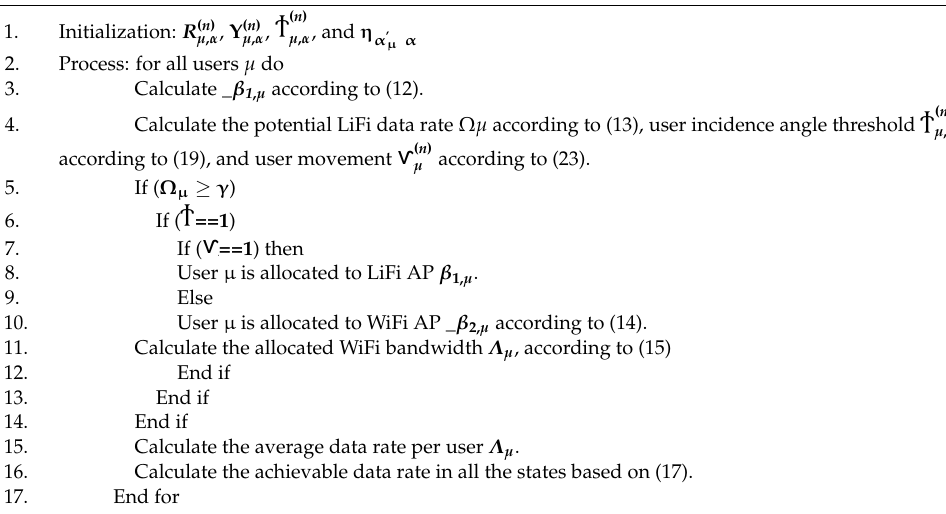
Algorithm 2 Load balancing algorithm in each state for the TPHM-APT